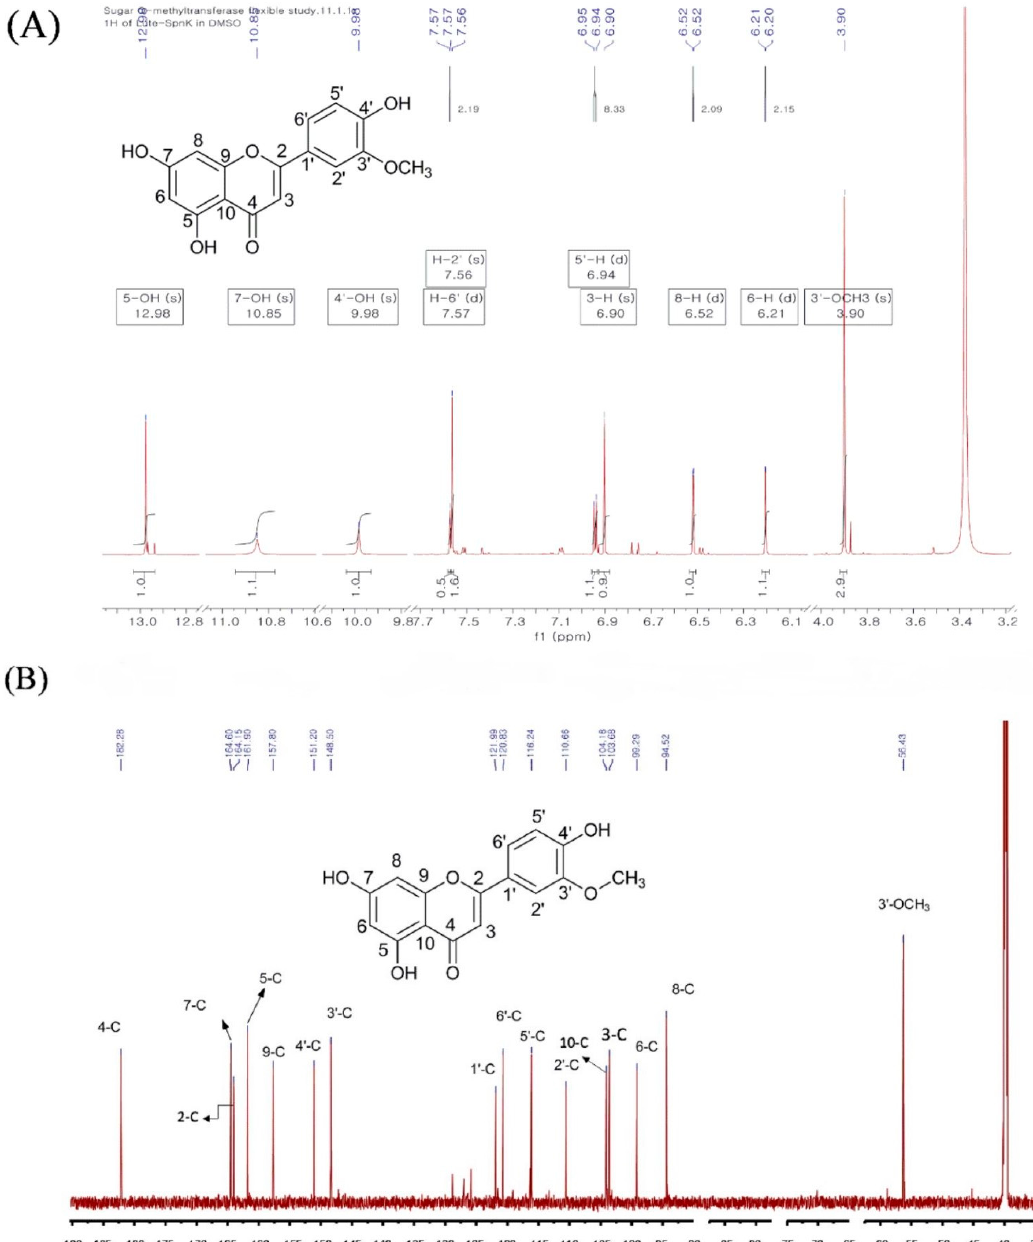
Figure 3. NMR analysis. ( A ) 1 H-NMR and ( B ) 13 C-NMR spectra of chrysoeriol isolated after the biotransformation of luteolin from recombinant E. coli harboring the PET28a+SpnK